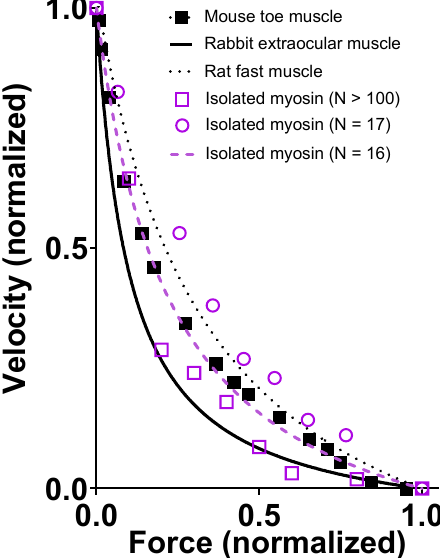
experimental data (“Exptl.”, stars and dashed line) at 1.2 mM MgATP from A. Simulated data shown